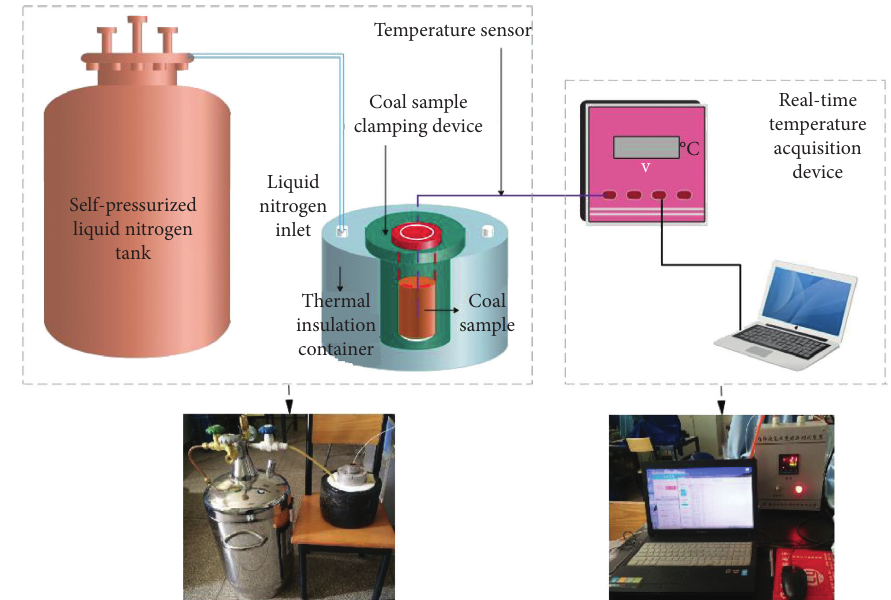
Figure 1: Experimental system for liquid nitrogen freezing and real-time temperature measurement.